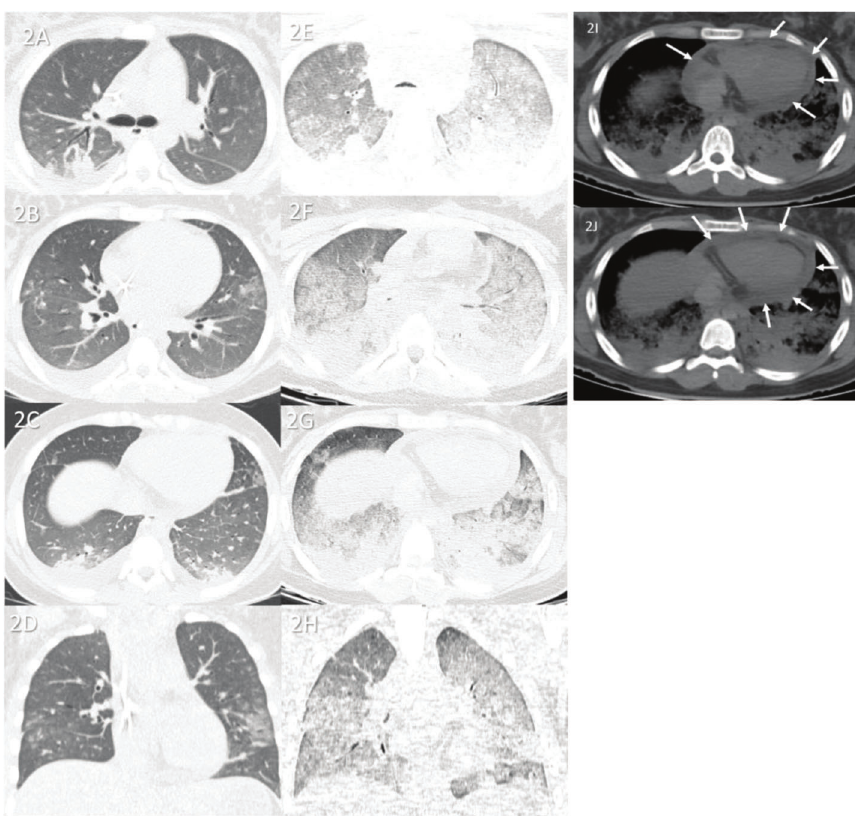
Figure 2 - Case 2: Premortem axial chest computed tomography (CT) of the upper (A), mid (B), and inferior (C) thirds of the lungs obtained 2 days before death showing peripheral ground-glass opacities, small posterior bilateral consolidations, and right pleural effusion. Postmortem axial chest CT of the upper (E), mid (F), and inferior (G) thirds of the lungs obtained 14 h 03 min after death showing a diffuse ‘‘ crazy paving ’’ pattern, possibly because of acute respiratory distress syndrome and subsequent death. Furthermore, the posterior bilateral consolidations are larger on postmortem CT than on premortem CT, indicating progression of the disease. Images D and H show pre- and postmortem coronal reformats, respectively. Postmortem axial chest CT (I and J) of the mediastinal window showing pericardial effusion (white arrows) related to myopericarditis (confirmed with the collected tissue sample as the probable cause of death).